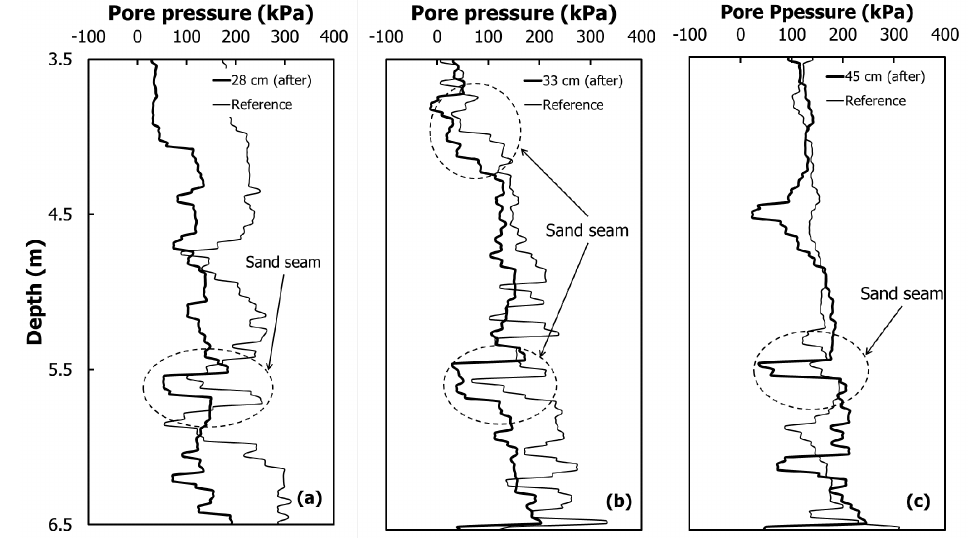
Figure 16. The variation of the pore pressure according to the horizontal distance from the electric heat pipe (Cases 5, 6 and 8), ( a ) a point 28 cm in the horizontal direction; ( b ) 33 cm; ( c ) 45 cm.